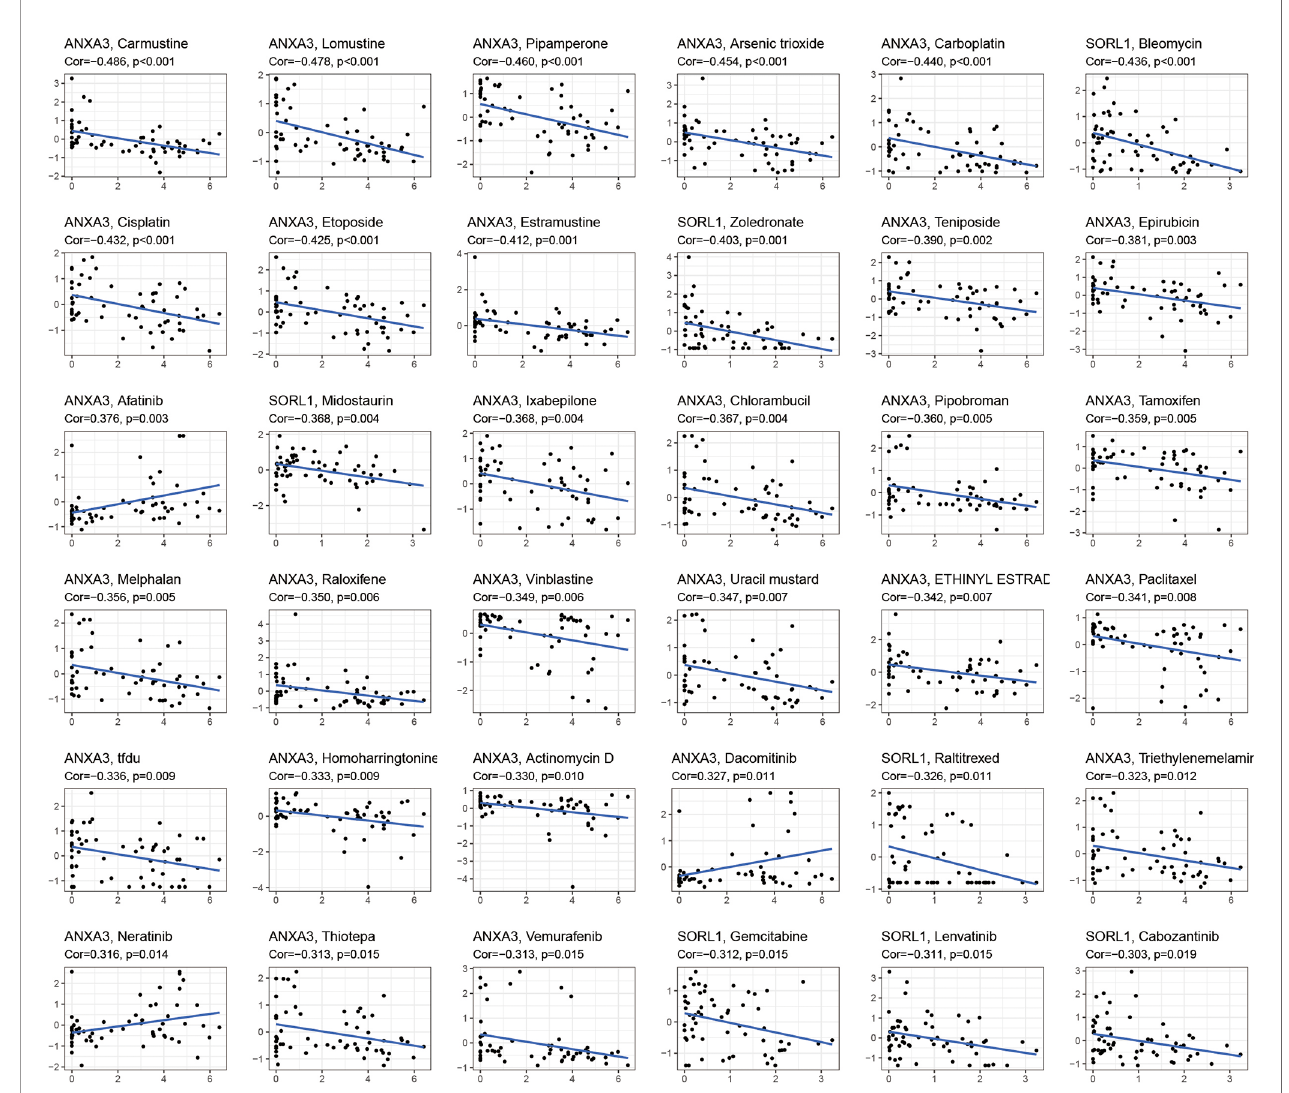
FIGURE 5 | Drug sensitivity analysis. The graph shows the drug sensitivity analysis of ANXA3 and SORL1 with various drugs. If Cor > 0, it means the gene is positively correlated with drug sensitivity, the higher the gene expression, the stronger the sensitivity of this drug; conversely, Cor < 0 means the gene is negatively correlated with drug sensitivity, the higher the gene expression, the worse the sensitivity of this